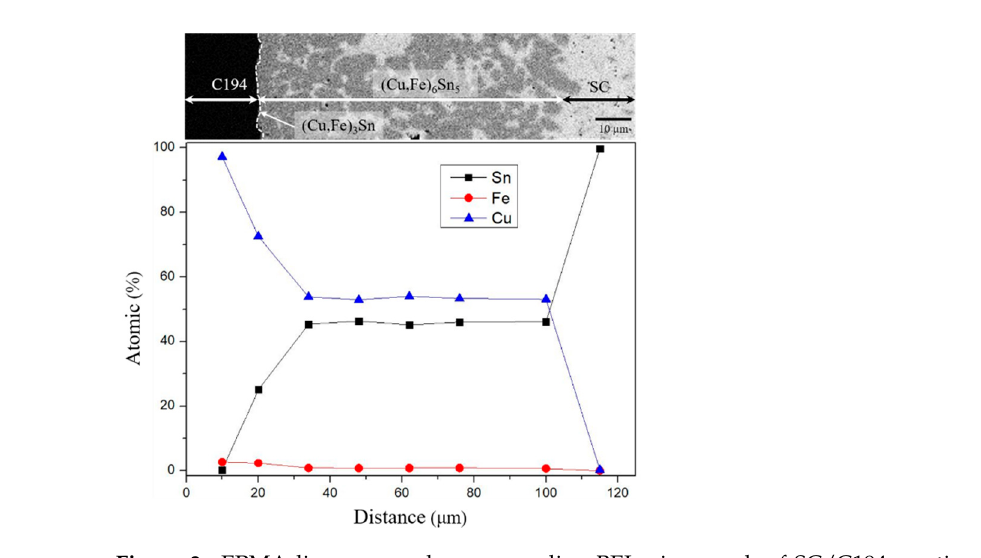
Figure 2. BEI micrographs of the shallow etched SC/C194 interfaces reacted at 240 °C for ( a ) 0.5 h and ( b ) 2 h; reacted at 255 °C for ( c ) 0.5 h and ( d ) 2 h; and reacted at 270 °C for ( e ) 0.5 h and ( f ) 2 h; ( g ) BEI partial enlarged micrograph of the SC/C194 couples.